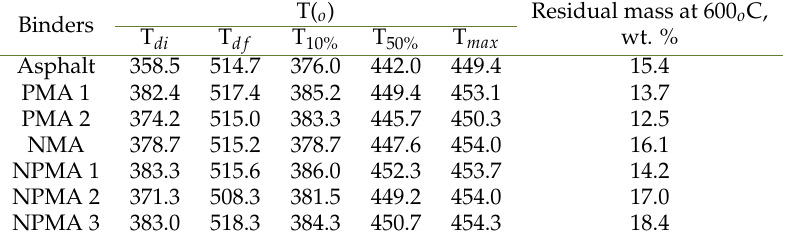
Table 4. Temperatures T di , T df , T 10% , T 50% , T max and % residue of binders. T( o ) Residual mass at 600 o C, Binders T di T df T 10% T 50% T max